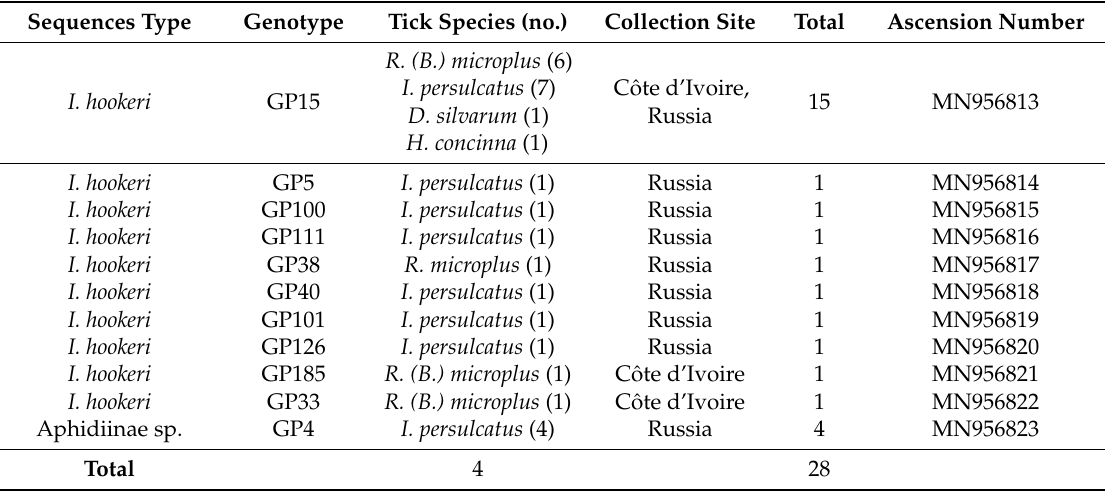
Table 2. Sequences of parasitoid wasps amplified in this study and deposited in